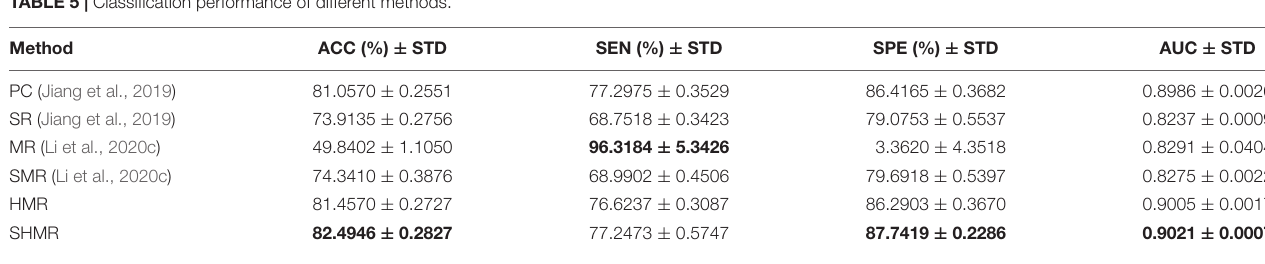
TABLE 5 | Classification performance of different